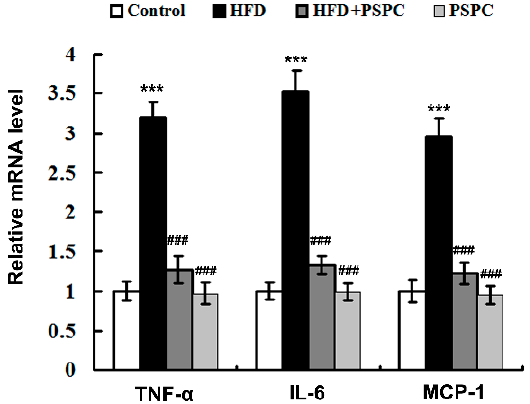
Figure 7. PSPC suppresses inflammation-related genes expressions in HFD-treated mouse livers ( n = 3). The mRNA level of inflammation-related genes in mouse livers. All of the values are expressed as the mean ± SD. *** p < 0.001 vs. the control group; ### p < 0.001 vs. the HFD group.